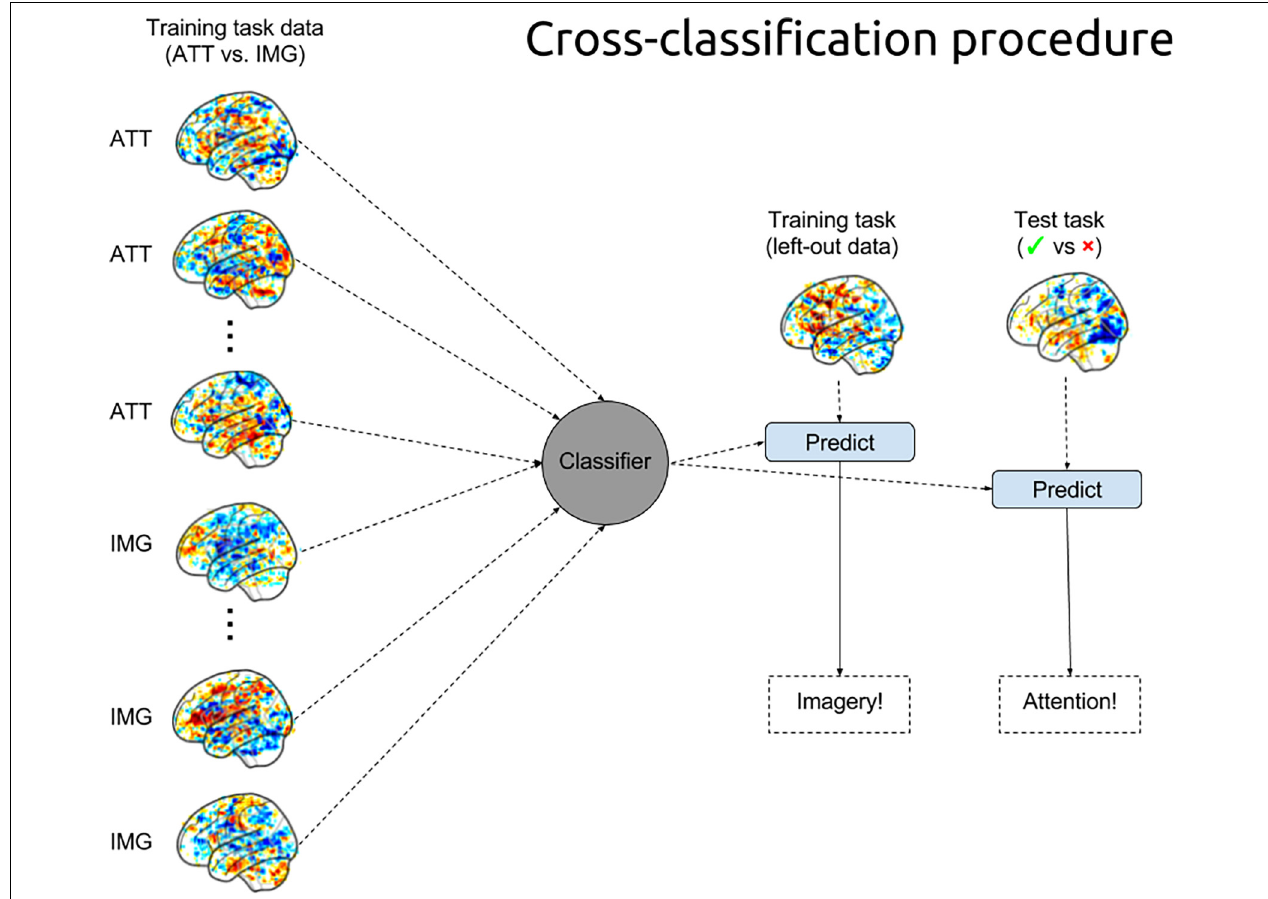
FIGURE 3 | MVPA training and cross-classification procedures. The pattern classifier was trained on 90% of the data of each participant in the training task to distinguish attention (ATT) trials from imagery (IMG) trials and was used to predict (and evaluate) the remaining trials from the training task as well as to predict the trials from the test task (i.e., the cross-classification of the penalty-reading task) .